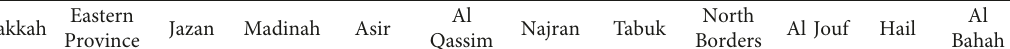
Table 5: Correlation matrix